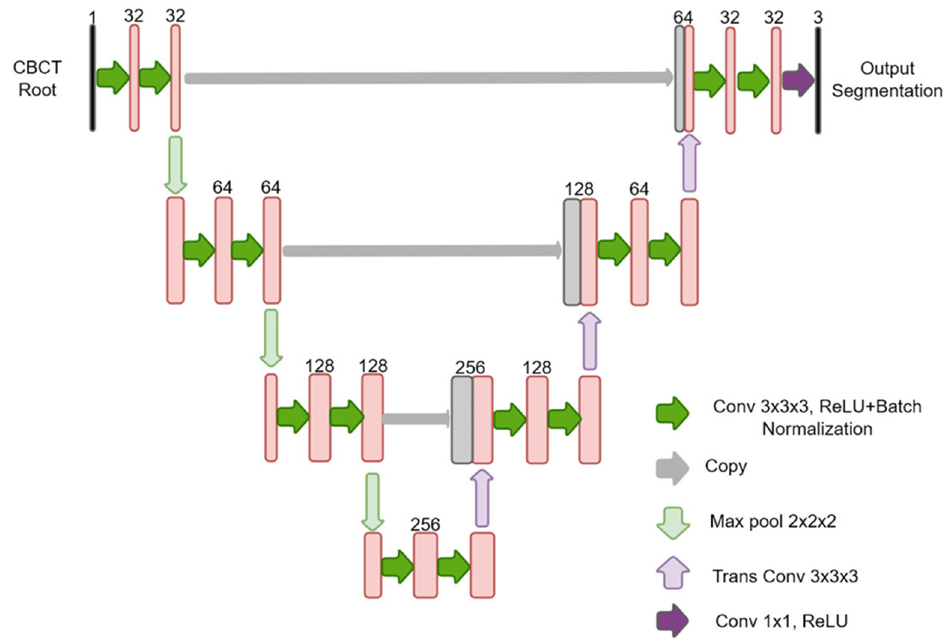
Figure 1. The U-Net architecture used in this study.